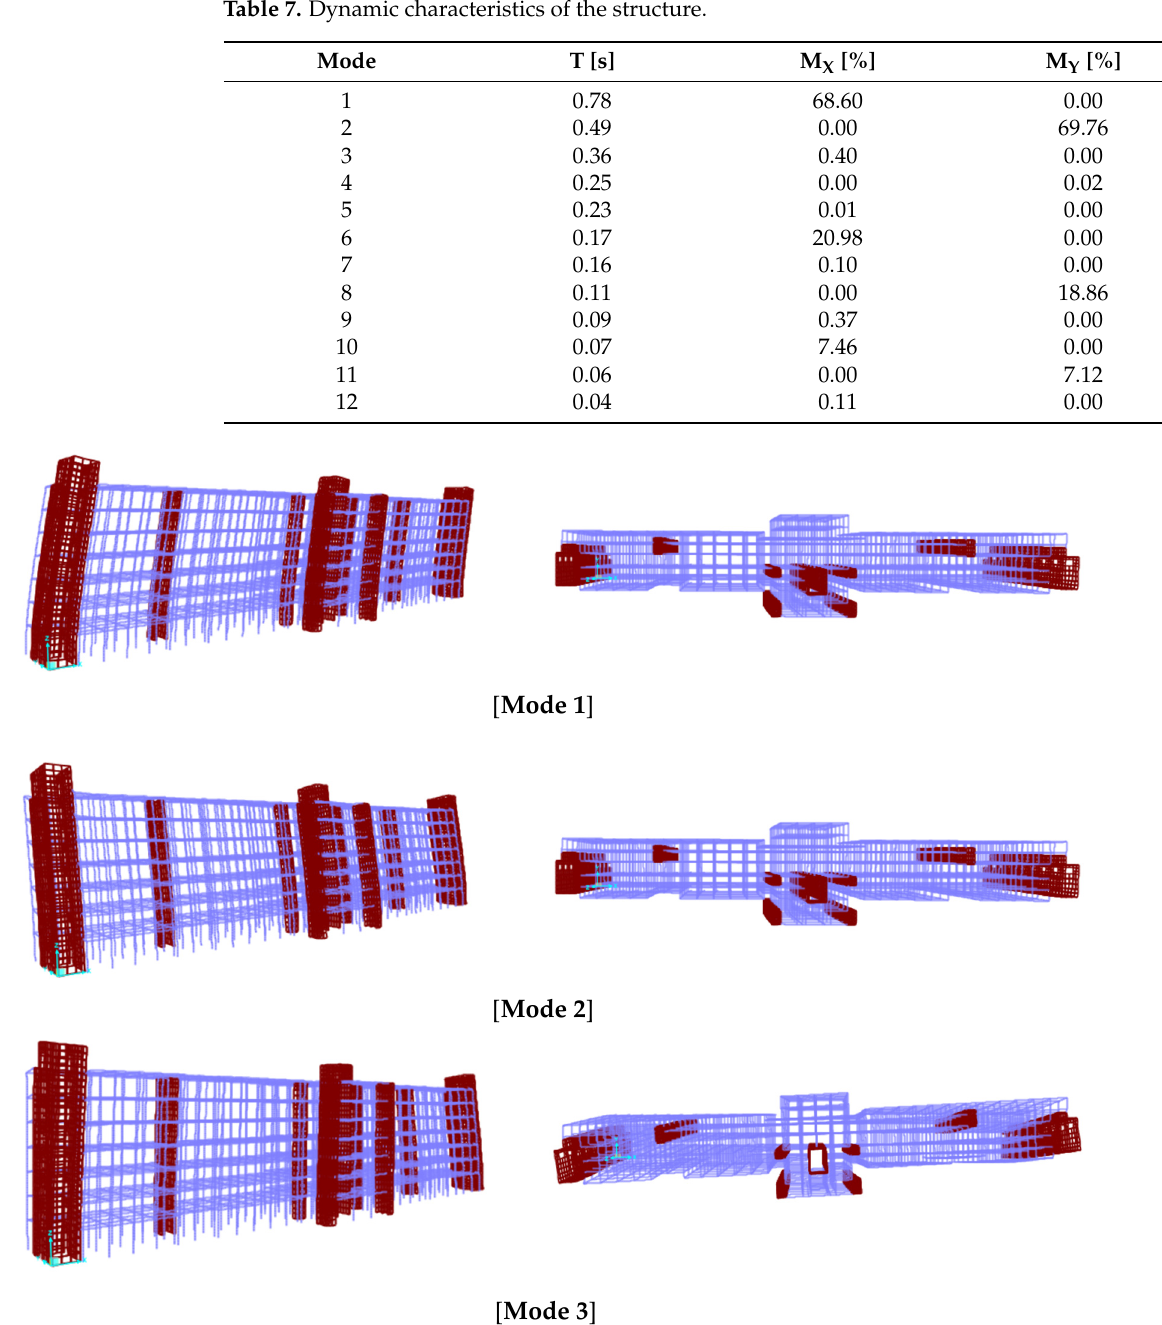
Figure 8. The first three mode shapes of the structure. Table 7. Dynamic characteristics of the